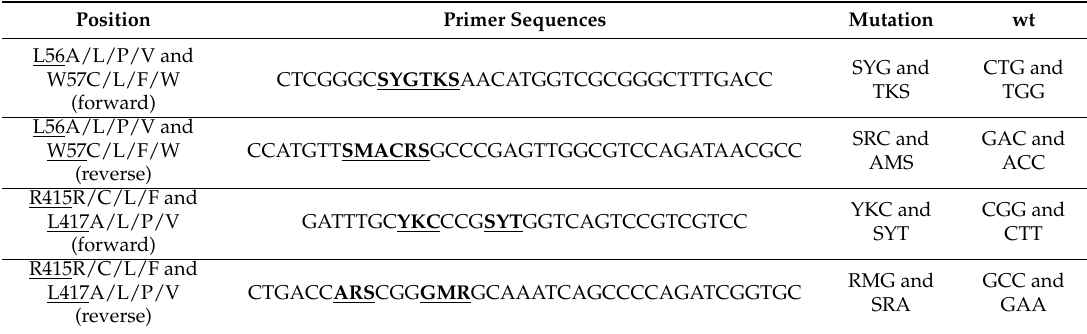
Table 3. Overview of the primers used for generating the library. The mutated codons are underlined and highlighted in